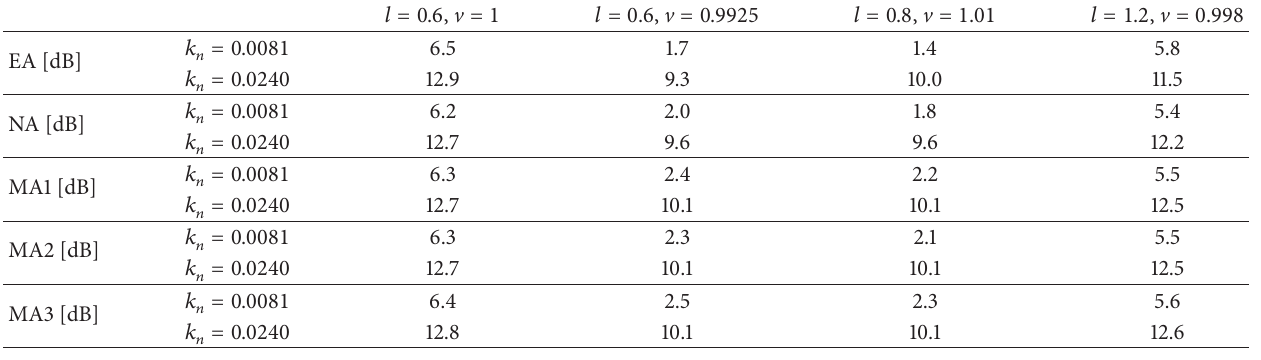
Table 7: Attenuations for the mode of the